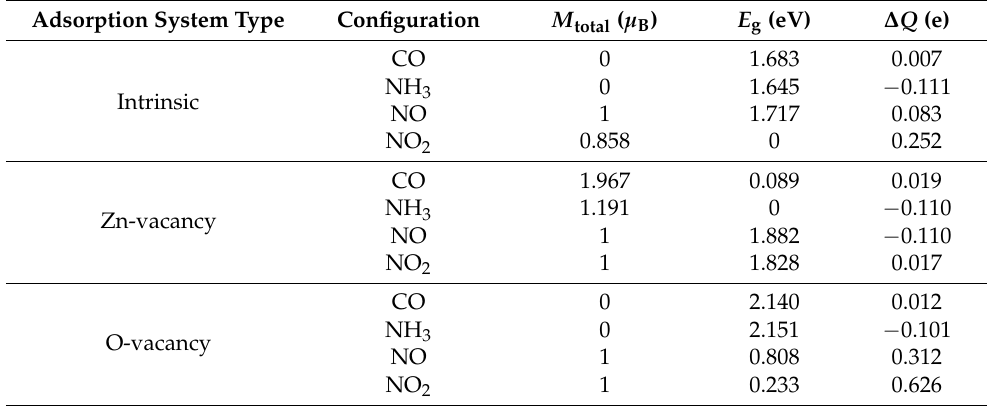
Table 1. The magnetic moments ( M total ), bandgap ( E g ), and charge transfer ( ∆ Q ) for the stable configurations of gas adsorbed on intrinsic g − ZnO, V Zn /g − ZnO, and V O /g −